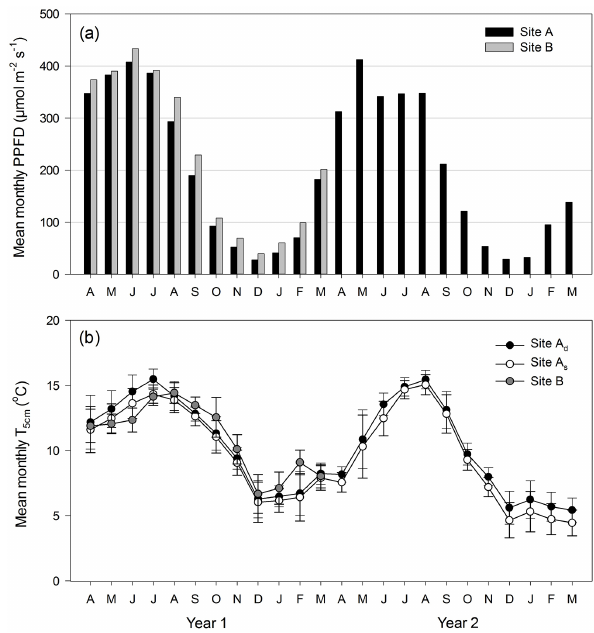
Figure 2. (a) Mean monthly Photosynthetic Photon Flux Density (PPFD) (µmolm − 2 s − 1 ) at Site A (April 2011 to March 2013) and Site B (April 2011 to March 2012) and (b) mean monthly soil tem- perature at 5cm depth ( T 5cm ± standard deviation) at Site A d , Site A s and Site